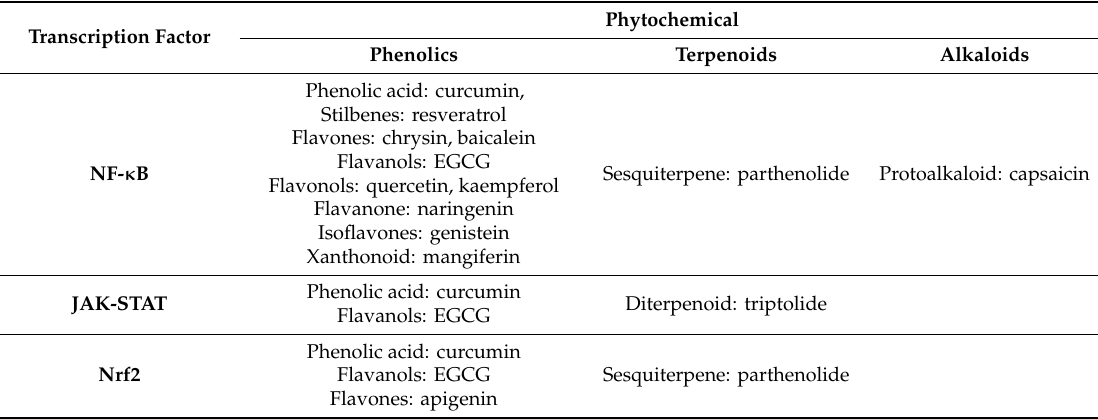
Figure 1. The percentage of e ff ective phytochemicals in each prevalent inflammatory disease according to the summary of Tables 1–3. Phenolic compounds (blue) dominate all inflammatory diseases. Terpenoids (orange) are secondary dominant compounds in rheumatoid arthritis. In Alzheimer’s disease, alkaloids (gray) are secondary dominant compounds. Table 4. Phytochemical categorization depending on the inflammation-associated transcription